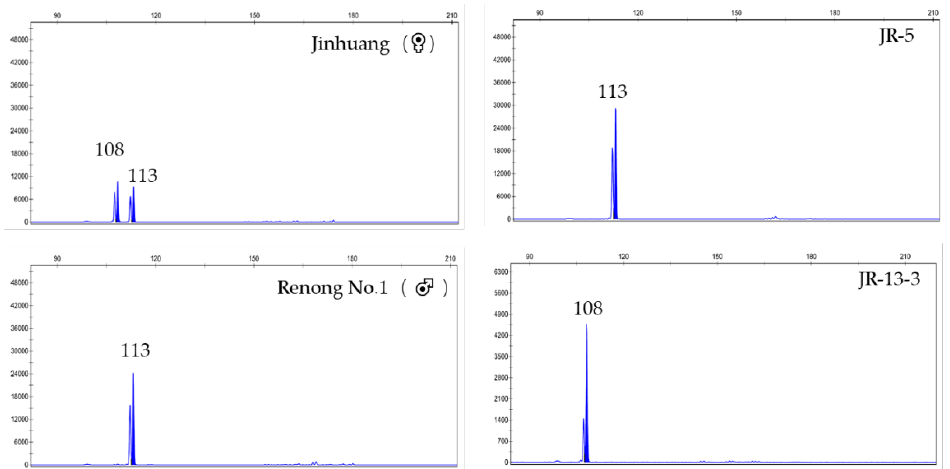
Figure 2. Capillary electrophoresis results obtained with ES55 in ‘Jinhuang’, ‘Renong No.1’, true hybrid JR-5, and false hybrid JR-13-3.